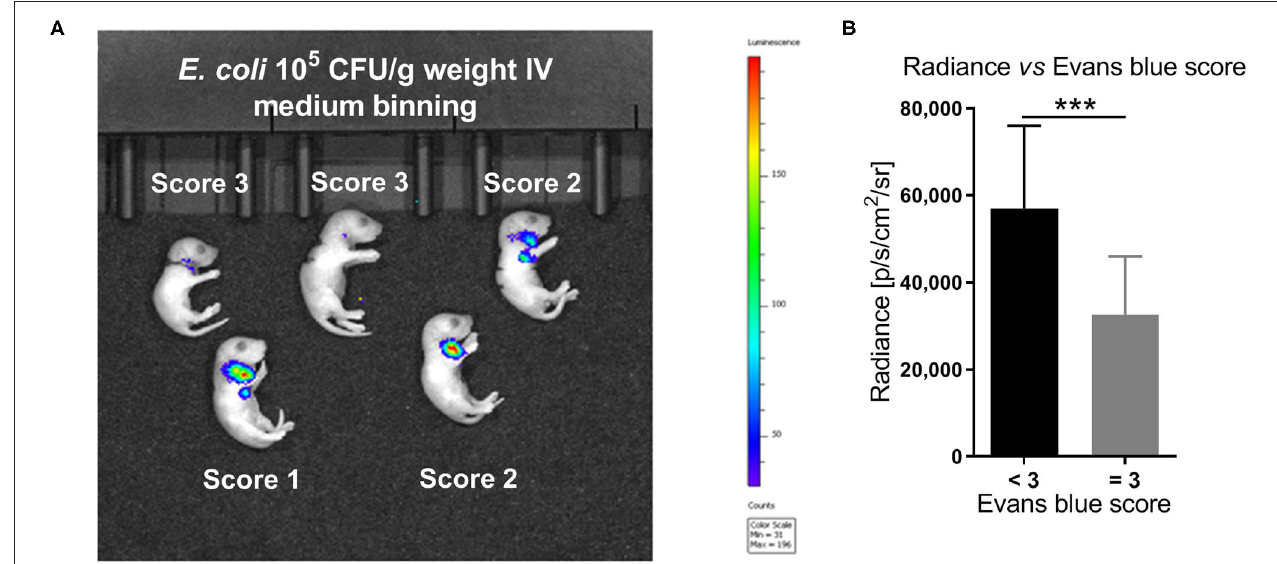
FIGURE 3 | In vivo imaging of bioluminescent E. coli correlated with Evans blue IV injection score. (A) Optical imaging following IV injection of 10 5 CFU per g body weight of the bioluminescent E. coli A192PP- lux2 strain (34). The representative image shows the corresponding Evans blue IV injection score for each animal. (B) The average radiance measured shortly after IV injections correlated with the estimated Evans blue IV injection score (Spearman correlation r = − 0.51, 95% confidence interval: − 0.61 to − 0.41, p < 0.001, n = 230). Significant difference between median (IQR) radiance derived from animals with Evans blue scores < 3 vs. = 3 was as indicated: *** p < 0.001, 2-sided Mann-Whitney U